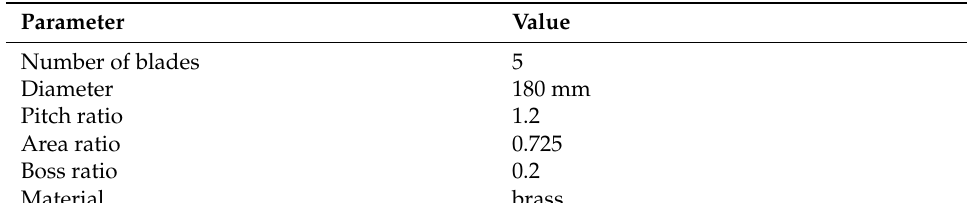
Table 2. Basic information of test propeller.